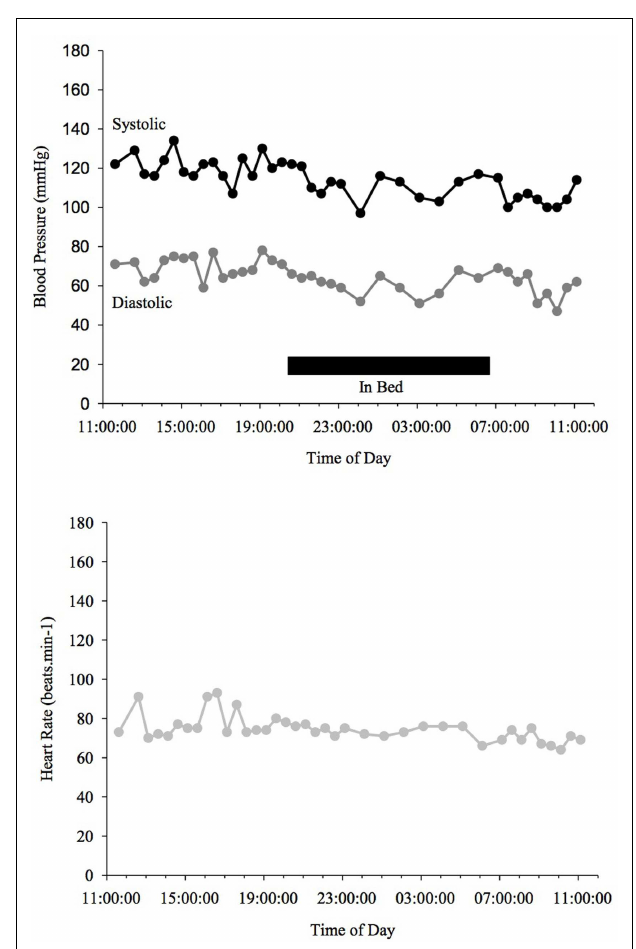
FIGURE 3 | Blood Pressure (upper line systolic, lower line diastolic) and heart rate profiles during 24hABPM of a PD patient, non-dipper, not showing a drop ( < 10%) of BP at night time. Black bar indicates